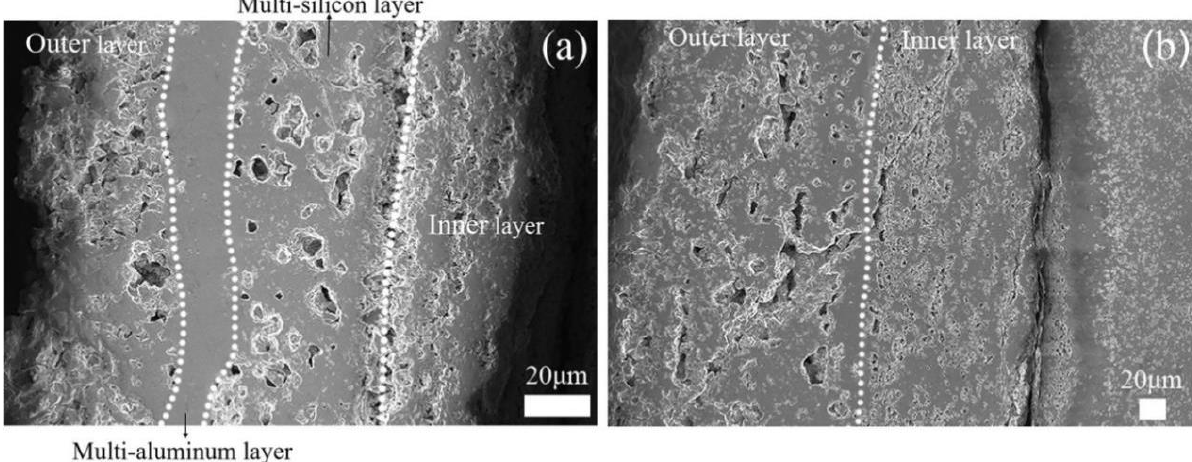
Figure 8. Cross-section of the oxide layer after oxidation of ( a ) TSC60 and ( b ) TSC50 at 1400 °C for 20 h.